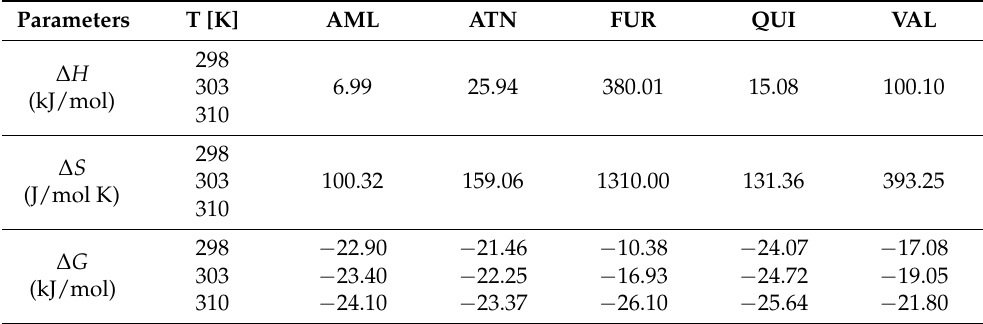
Table 2. Thermodynamic parameters of BSA–GLICL complex in presence of DRUG ligands (AML, ATN, FUR, QUI, VAL) at different temperatures: 298, 303, and 310 K. Parameters T [K] AML ATN FUR QUI